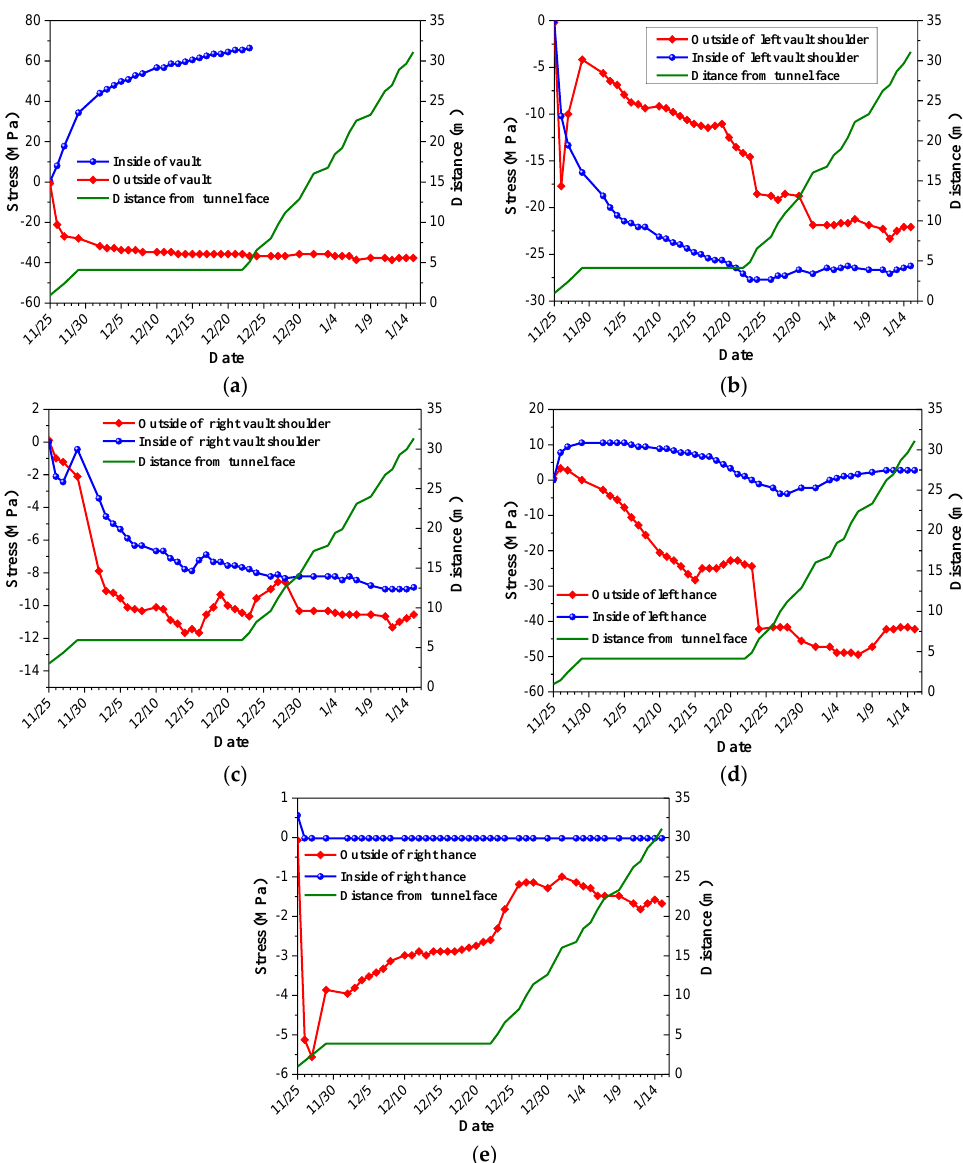
Figure 10. Monitoring results of steel arch stress in Section 4: ( a ) vault; ( b ) left vault shoulder; ( c ) right vault shoulder; ( d ) left hance; ( e ) right hance.